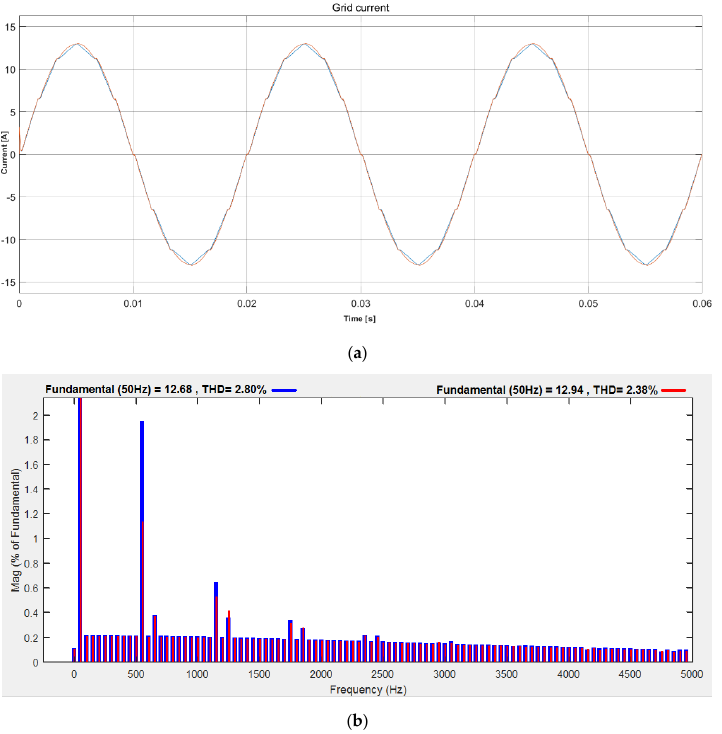
Figure 17. Grid current ( i L1 ) drawn by the rectifier with CM current modulator (based on H-bridge with output filter) and CM 2 supporting system: ( a ) waveform, ( b ) spectral analysis. Energies 2021 , 14 , x FOR PEER REVIEW Figure 18 shows, respectively, the grid current waveforms and their spectral analysis for the case of the diode rectifier with the CM current modulator based on the transistor H-bridge and with the CM 2 support system in on and off state.